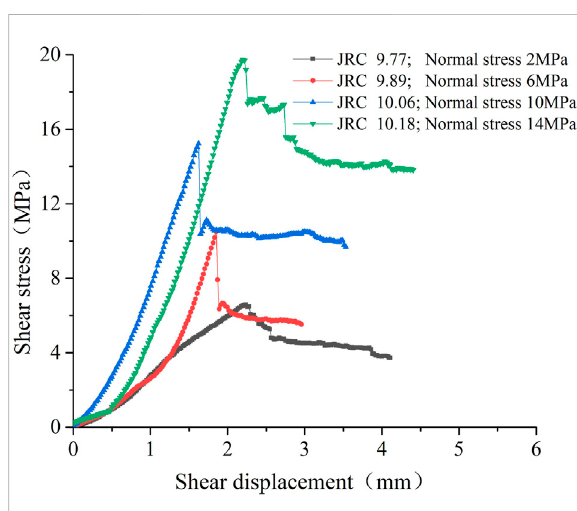
FIGURE 5 Shear stress-strain curves of the structural plane under different normal stress and JRC